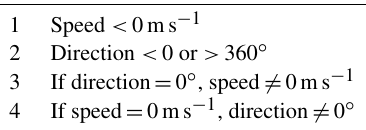
Figure 5. The dynamic threshold assignment from the im- proved streak check on dew point temperature data from 724750– 99999 Milford Municipal Airport (38.4 ◦ N, 113.0 ◦ W, 1536m). Note the logarithmic y axis, and hence the linear inverse decay curve in blue. The threshold used in HadISD.1.0.0 (green) retained a large number of streaks of repeated values which are now removed from this station when using the new threshold (red). Table 1. Logical wind checks used in HadISD.2.0.0, adapted from DeGaetano